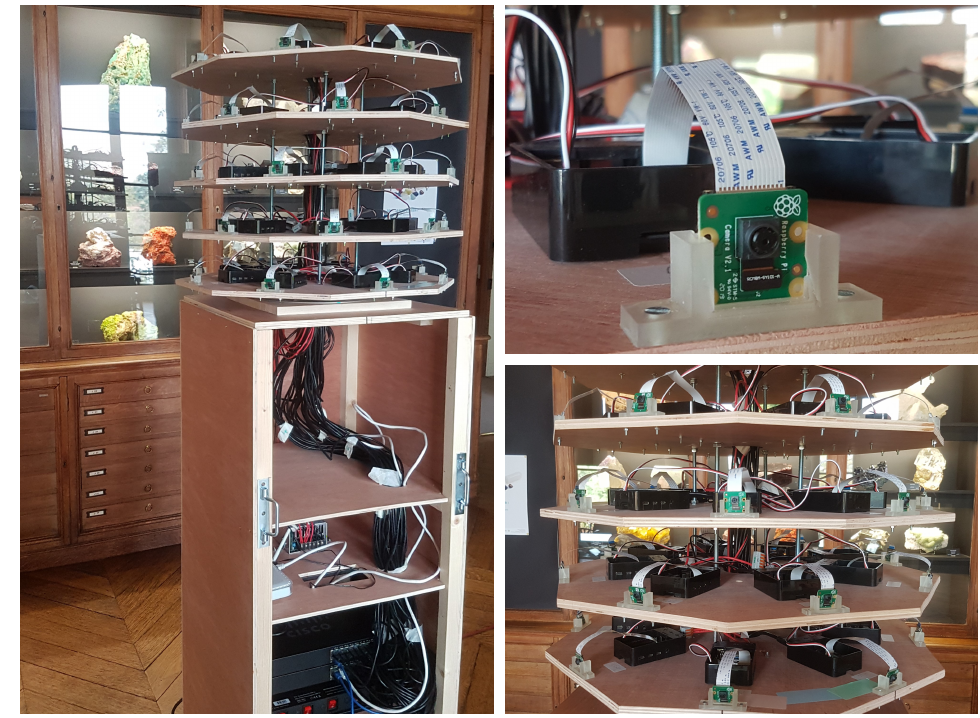
Figure 3. Our rotating 40-camera system for multi-view